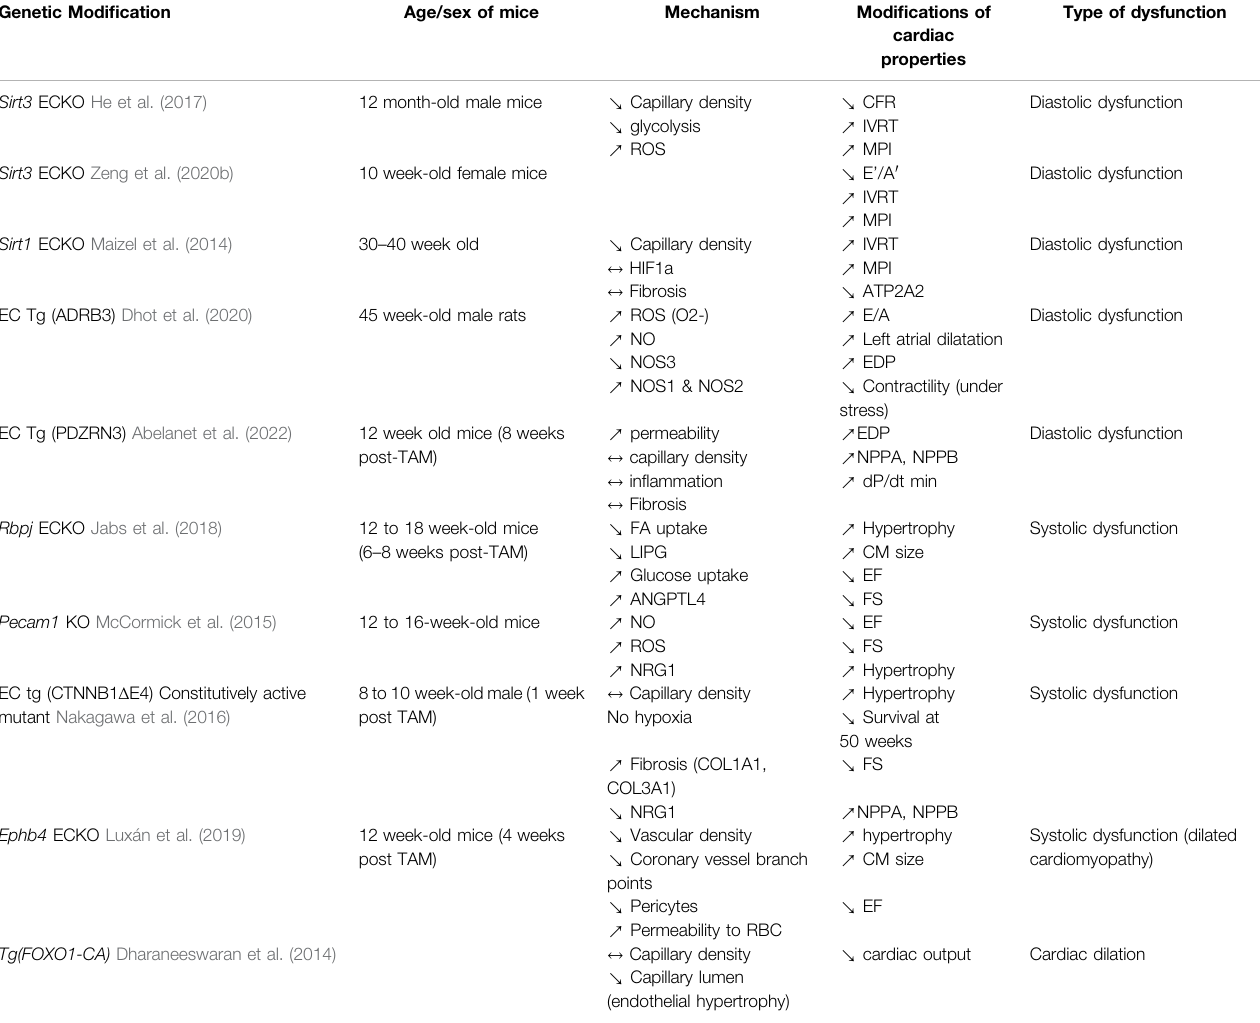
TABLE 1 | Genetic modi fi cations of EC suf fi cient to induce cardiac dysfunction. Genetic Modi fi cation Age/sex of